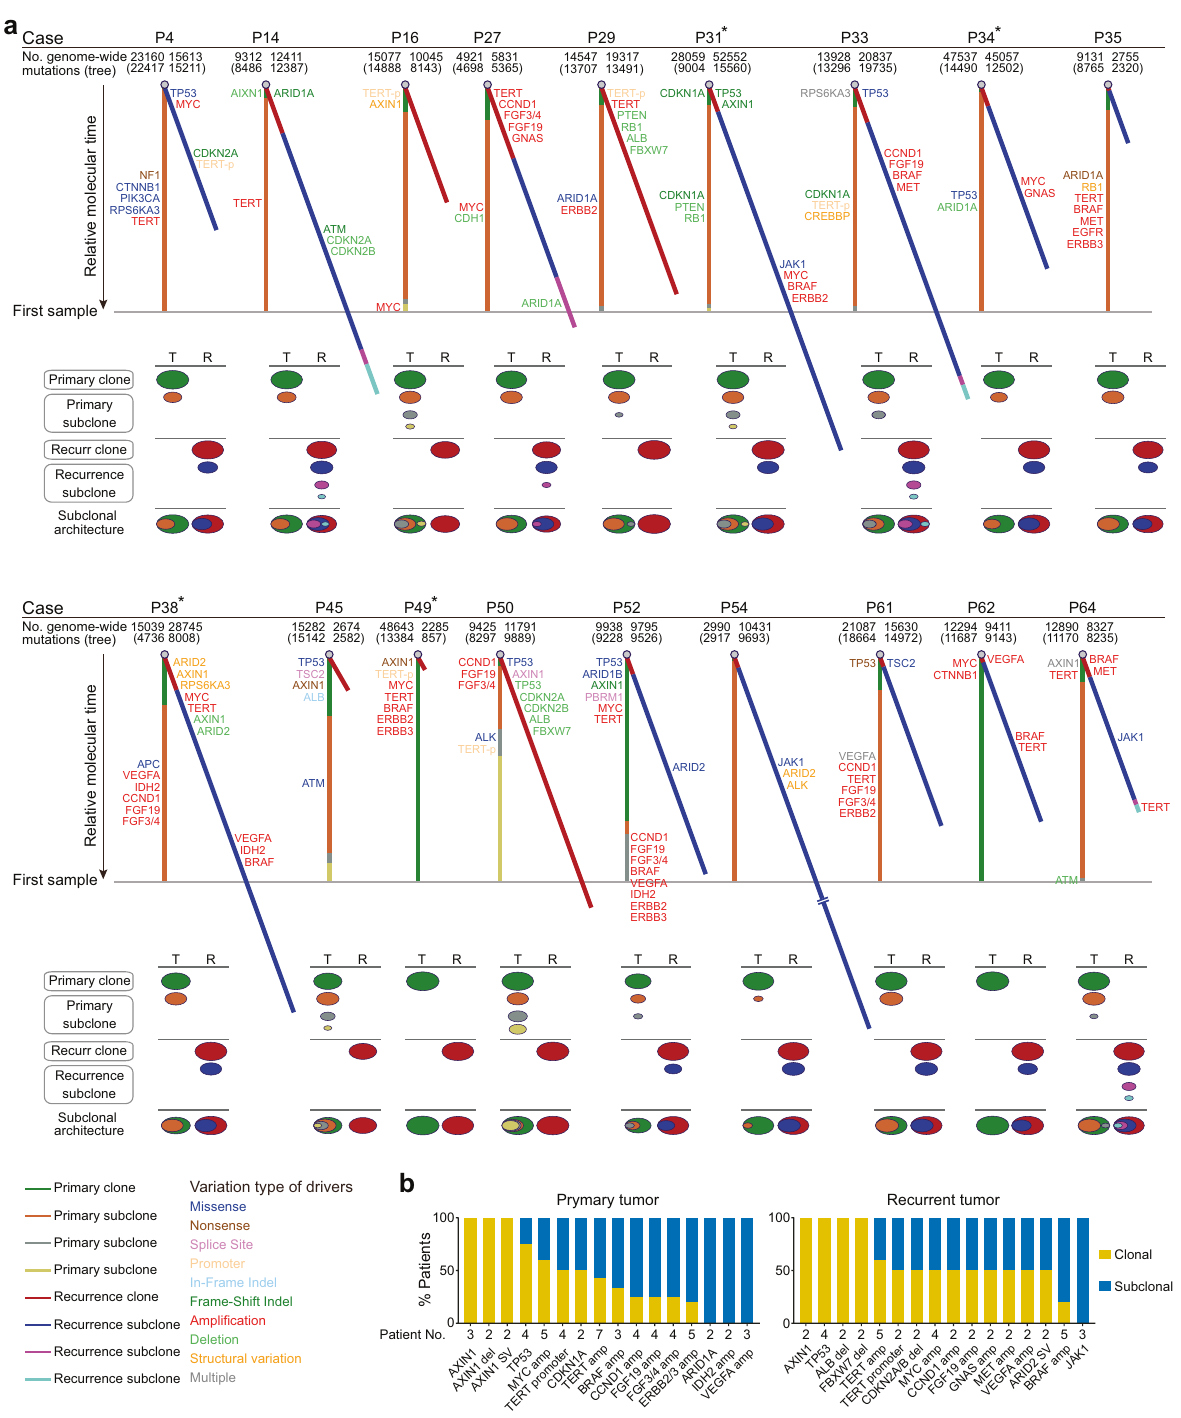
Fig. 4 Phylogenetic trees and subclonal architectures underlying the evolutionary trajectory of tumor early recurrence in 18 HCCs with de novo recurrence. a Each tree and corresponding subclonal architecture represents an individual patient. Trees were derived from genome- wide somatic mutations (SNVs + indels) based on subclonal architectures. The numbers of all somatic mutations per patient are labeled above the tree (the numbers of somatic mutations involved in constructing the phylogenetic trees are labeled in brackets). The asterisk indicates that trees and subclonal architectures were derived from somatic mutations in genic region. Line lengths re fl ect the proportion of clustered somatic mutations attributed to that clone or subclone. The whole tree is scaled to the maximum length of a tree that would be inferred from mutations identi fi ed in the primary tumor. In the subclonal architecture panel, the diameter of each oval with color is proportional to the estimated CCF, which re fl ects the proportion of cells in that sample that contain the mutations that constitute the same color of the relevant phylogenetic tree. b The relative fraction of patients in whom the indicated somatic alterations of drivers occupied the clone or subclone of their respective phylogenetic trees. The numbers of patients with each of the indicated somatic alterations are labeled